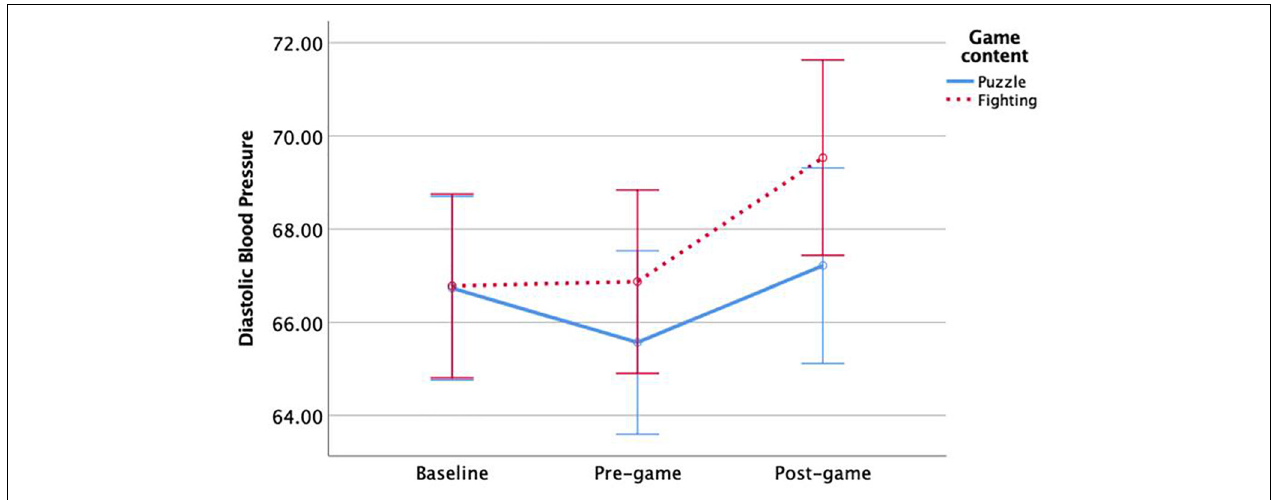
FIGURE 3 | Significant interaction effect of game content on diastolic blood pressure over time. Error bars are 95% confidence intervals.